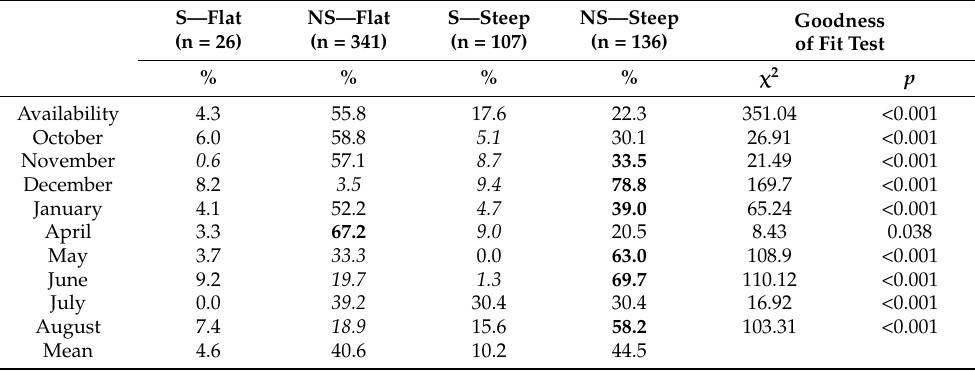
Table 1. The availability of different areas and the relative proportion of boar rooting grouped by slope and steepness in different months with the results of the Chi 2 test. Bold values indicate a significant preference, and italics shows significant avoidance.